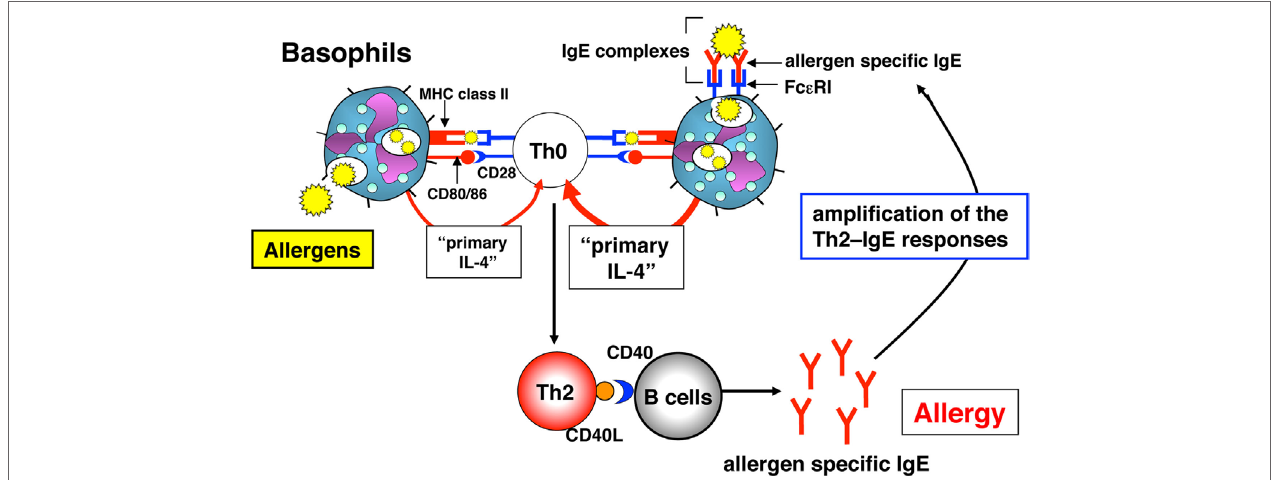
FigURe 3 | The role of basophils in the induction and amplification of T helper (Th)2 cell responses. Basophils initially induce Th2 cells in vivo via “primary interleukin (IL)-4” production and the presentation of complexes of allergen peptide plus MHC class II to CD4 + T cells. These activated Th2 cells produce IL-4 and express CD40 ligand (CD40L), which, in combination, induce B cells to proliferate and produce allergen-specific IgE in vivo . Immune complexes of allergen and allergen- specific IgE “preferentially” augment the development of allergen-specific Th2 responses in an endogenous basophil-dependent